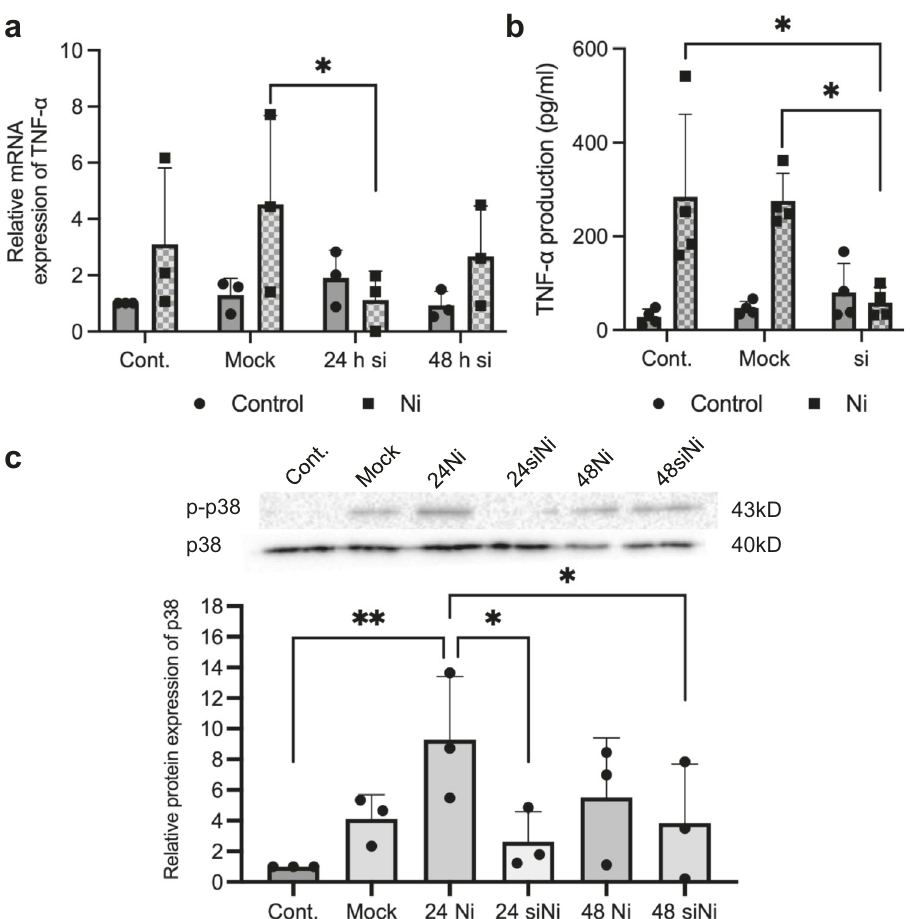
Fig. 2 Sema3A-silenced Pam2.12 cells show suppressed TNF- α expression and MAPK activation upon Ni stimulation. a TNF- α mRNA expression in Sema3A siRNA-treated Pam2.12 cells after NiCl 2 stimulation analyzed using quantitative RT-PCR. Gene expression was normalized to levels of β -actin. 24h si/48h si represents Sema3A siRNA-treated groups with or without 24/48h of NiCl 2 stimulation. N = 3. b TNF- α protein production in Sema3A siRNA- treated Pam2.12 cells after NiCl 2 stimulation analyzed by ELISA. The samples with or without NiCl 2 stimulation were collected 24h after stimulation. N = 4. c Inhibited p38 phosphorylation in Sema3A siRNA-treated Pam2.12 cells after NiCl 2 stimulation analyzed by western blotting analysis. 24 Ni/48 Ni represents the groups after 24/48h of NiCl 2 stimulation. 24 siNi/48 siNi represents the Sema3A siRNA-treated groups after 24/48h of NiCl 2 stimulation. N = 3. The uncropped Western blotting image is shown in Supplementary Fig. 5b. Data are shown as mean± SD and are representative of at least three independent experiments. * p < 0.05, ** p < 0.01; One-Way ANOVA with LSD. Supplementary Data and p values are provided as a Supplementary Data fi